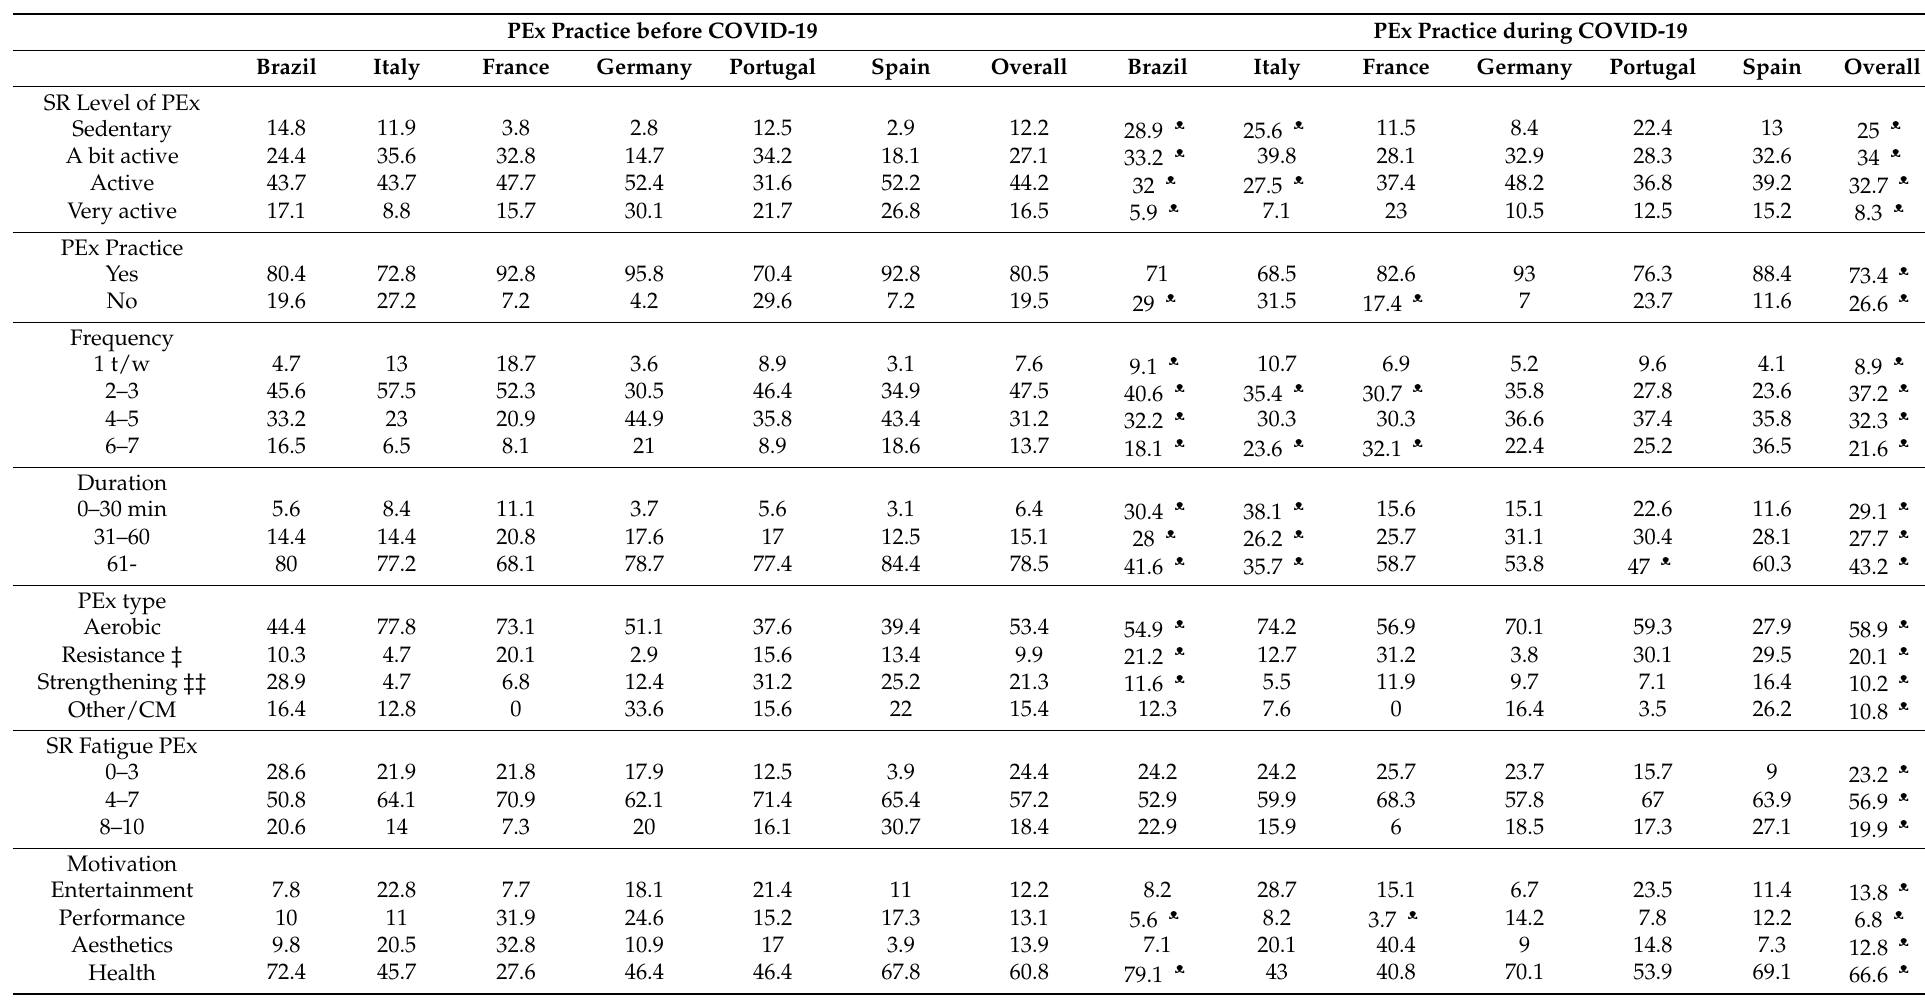
Table 4. Physical exercise practice and habits, and self-related fatigue of the sample from Brazil ( n = 1845), Italy ( n = 680), France ( n = 236), Germany ( n = 143), Portugal ( n = 152) and Spain ( n = 138), aged from 18 years old ( n = 3194), before and during the COVID-19 pandemic. Values are presented as percentages (%).